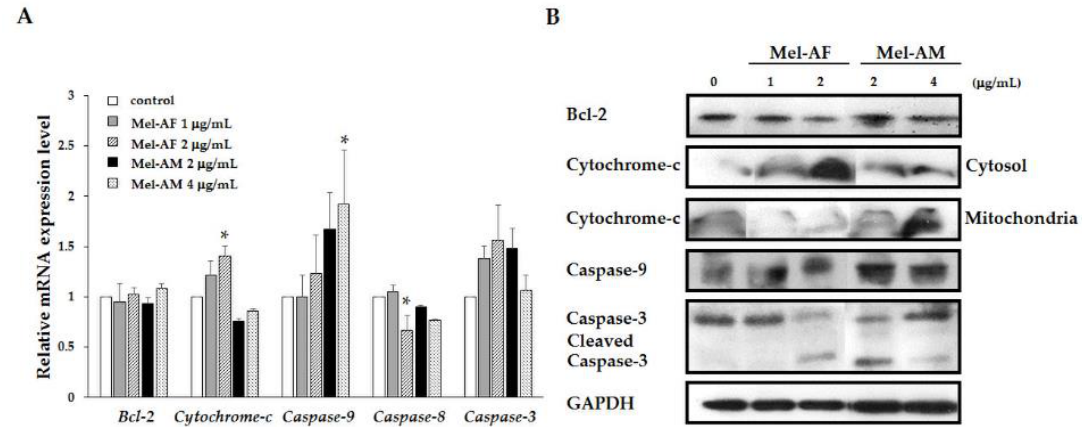
Figure 5. Mel-AF induced apoptosis-related gene and protein expression through the intrinsic mitochondrial pathway in A375 cells. ( A ) Apoptosis-related genes, including Bcl-2, cytochrome-c, caspase-9, -8 and -3, were examined by quantitative real-time PCR. Relative mRNA expression was normalized to GAPDH internal control. ( B ) Western blot analysis of apoptotic protein expression was employed involving Bcl-2, cytochrome-c, caspase-9 and -3 with specific antibodies. GAPDH was used as an internal control to show equal protein loading. Data are presented as mean ± SEM values of three independent experiments performed in triplicate. * p < 0.05 was determined by one-way analysis of